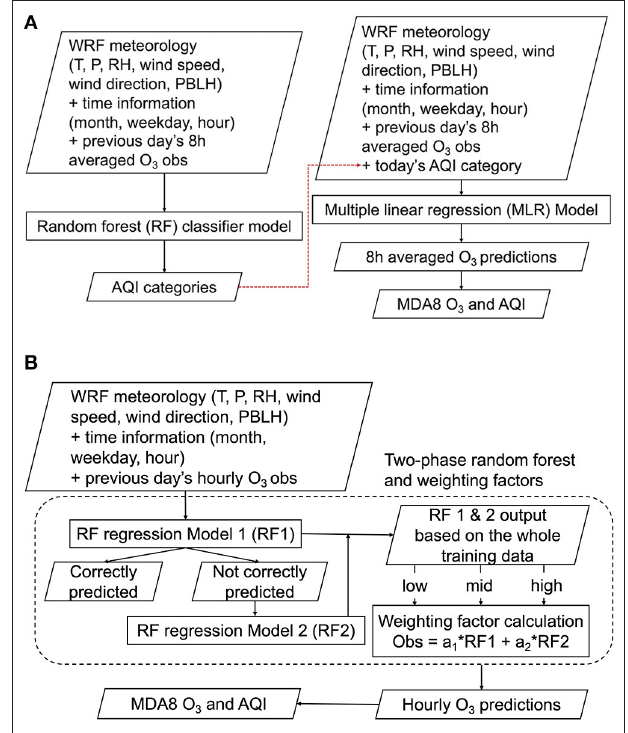
FIGURE 1 | (A) ML1 model based on random forest (RF) classifier and multiple linear regression (MLR) models (B) ML2 model based on a two-phase RF regression and weighting factors. (MDA8 O 3 : the maximum daily 8-hour moving average O 3 ).